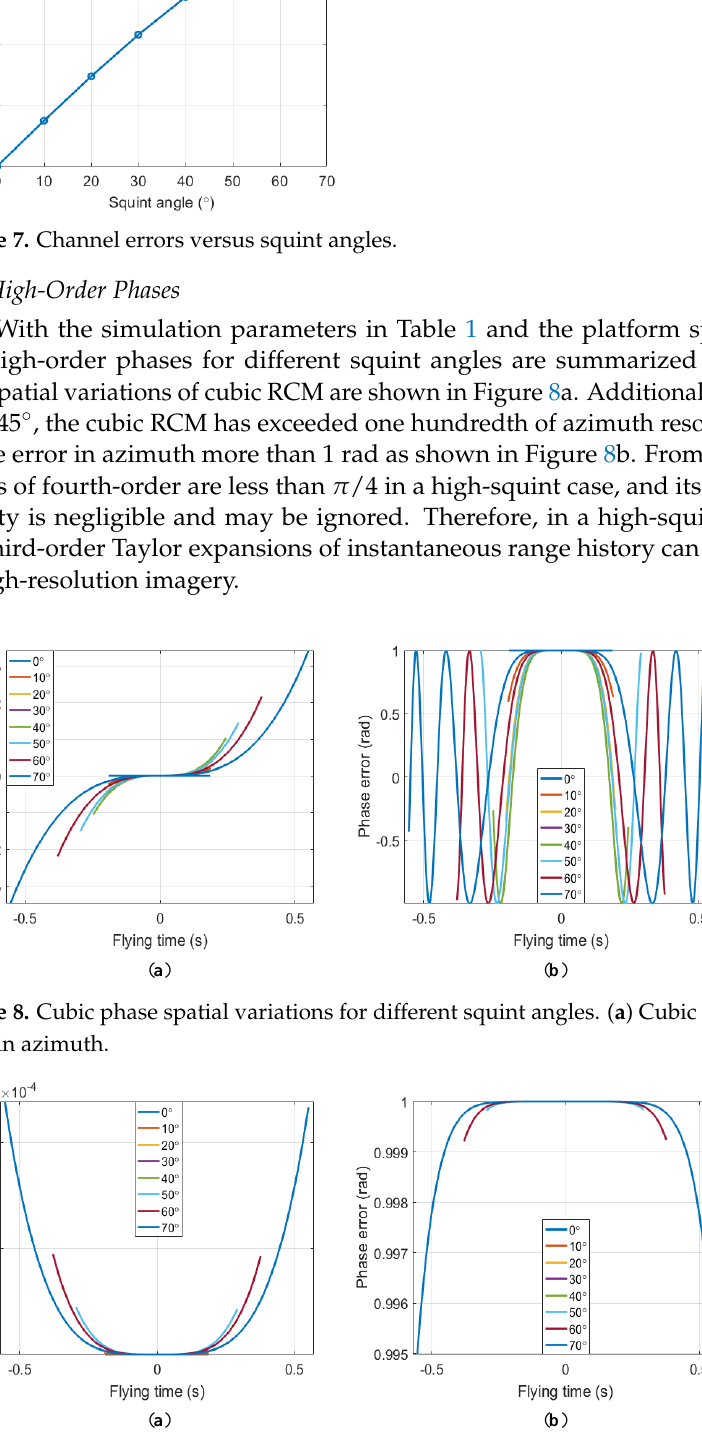
Figure 9. Fourth-order phase spatial variations for different squint angles. ( a ) Fourth-order RCM. ( b ) Fourth-order phase error in